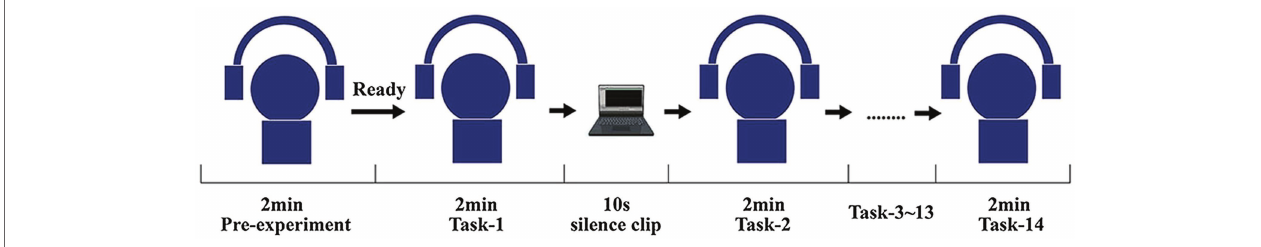
SD, standard deviation.